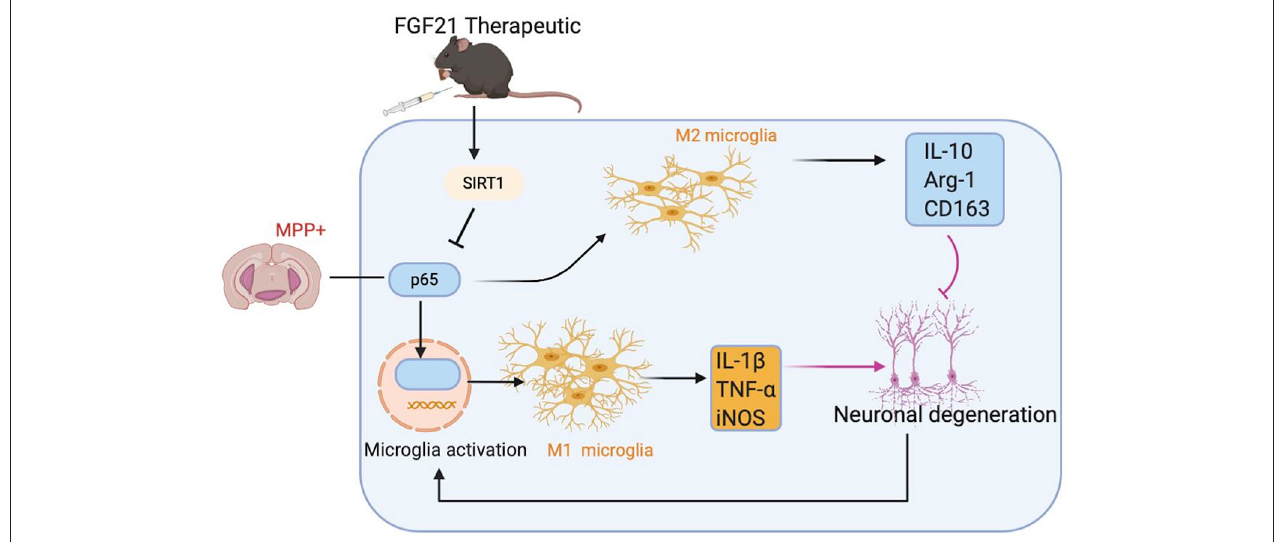
FIGURE 8 | Potential molecular mechanisms of FGF21 in treatment of PD via SIRT1/NF- κ B pathway-mediated microglial polarization. MPTP injection activates NF- κ B signaling in microglia, resulting in the microglial activation to assume an “M1” -like phenotype, producing pro-inflammatory cytokines, such as IL-1 β and TNF- α , which contributes to the death of dopaminergic neurons in MPTP-induced PD mice model and in SH-SY5Y neuronal cultures. FGF21 treatment inhibits NF- κ B signaling in microglia through upregulating SIRT1 expression, transforming activated M1 microglia to M2 microglia. M2 microglia then produces anti-inflammatory factors, such as IL-10, which result in strong neuroprotective effects in